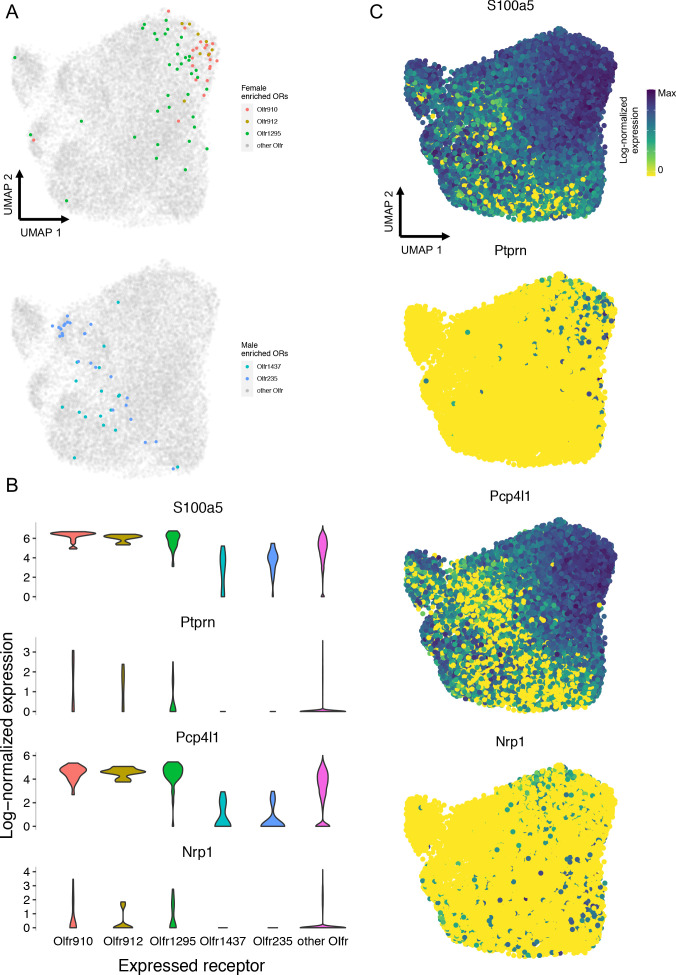
Single-cell RNA-Seq analysis reveals an enrichment of activity-associated gene expression in male OSNs expressing Olfr910, Olfr912, and Olfr1295.(A) Chemosensory receptor-independent UMAP embedding of 17,666 singly sequenced mature OSNs. OSNs expressing Olfr910, Olfr912, Olfr1295, Olfr1437, and Olfr235 are highlighted. (B) Gene expression analysis identified activity-associated genes S100a5, Ptprn, Pcp4l1, and Nrp1 to be enriched amongst OSNs expressing Olfr910, Olfr912, and Olfr1295. (C) UMAP representations of S100a5, Ptprn, Pcp4l1, and Nrp1 show a tendency toward higher expression where OSNs expressing Olfr910, Olfr912, and Olfr1295 are localized.Figure 8—source data 1.Summary statistics for Figure 8.